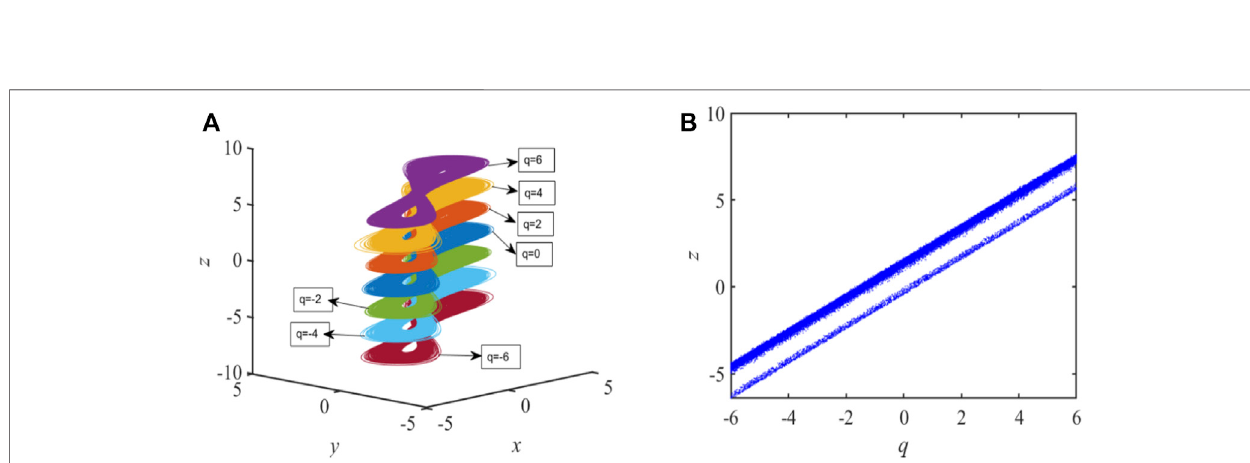
FIGURE 6 | Coexisting attractors in system (3) with a = 9, b = 11, c = 15, d = 11, k = 1.5, e = 5, g = 1 under original conditions (1, 1, 1, 1, x 0 ), x 0 (cid:1) − 11 π x 0 (cid:1) − 5 π x 0 = 0 x 0 (cid:1) − 3 π are for yellow, red, purple, and green correspondingly: (A) coexisting attractors in x – u plane (B) time-domain waveform.